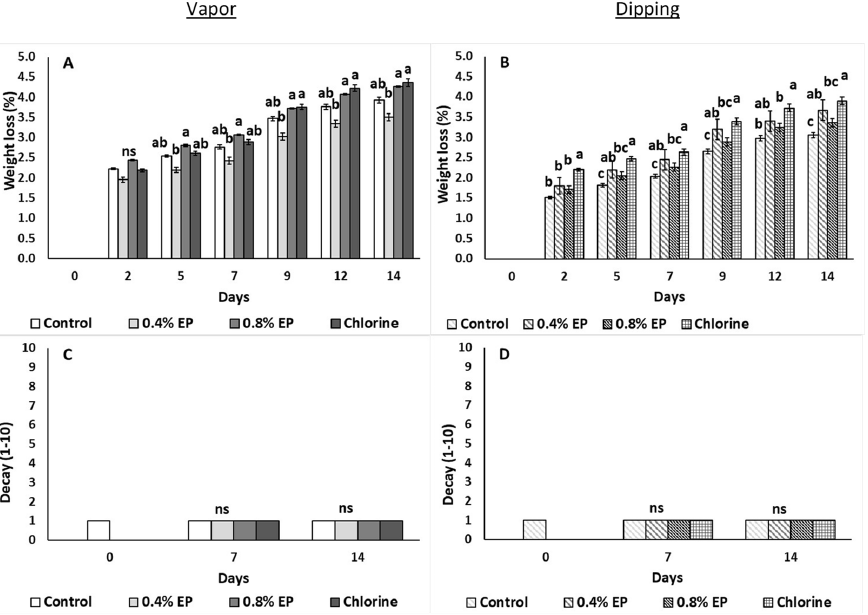
Figure 2. Effects of vapor ( A , C ) or dipping ( B , D ) application with eco-product (EP) at different con- centration (0–0.4% and 0.8%), chlorine (0.02%) or control (application with water) on weight loss (%) and decay (scale 1–10) of cucumber fruits stored at 11 °C and RH ~90% up to 14 days. Means ± SE followed by different Latin letters are significantly different according to Duncan’s MRT ( p = 0.05). ns: not